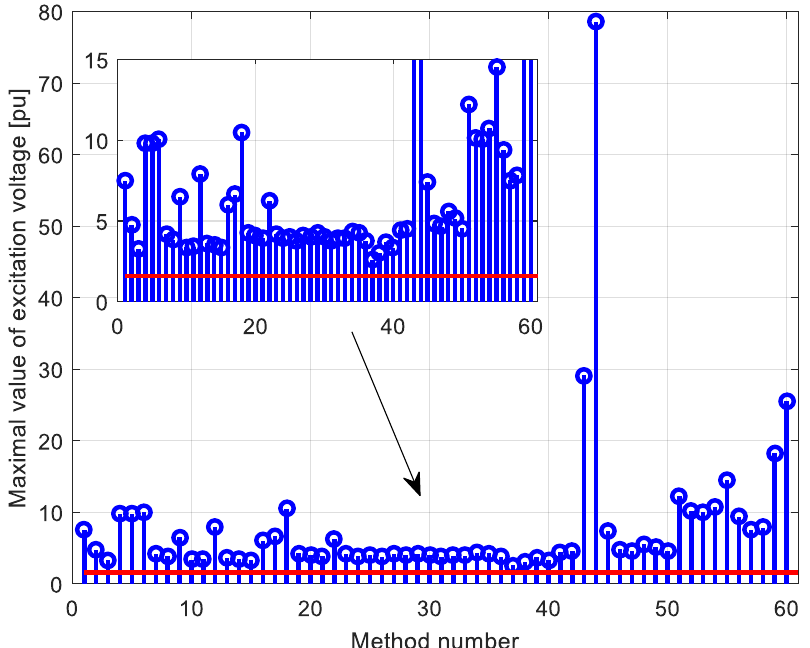
Figure 5. Overshoot of the generator voltage.